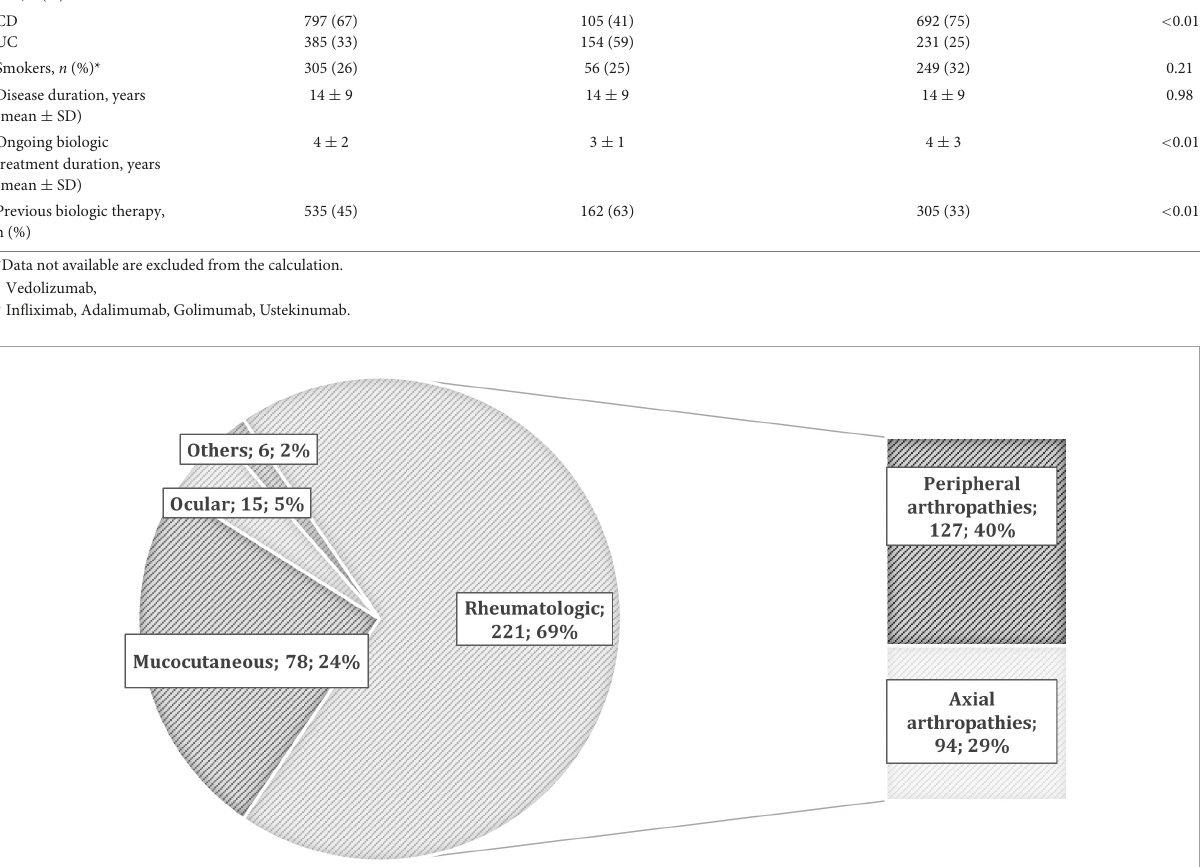
(12/174) of patients who were not taking DMARDs ( p =